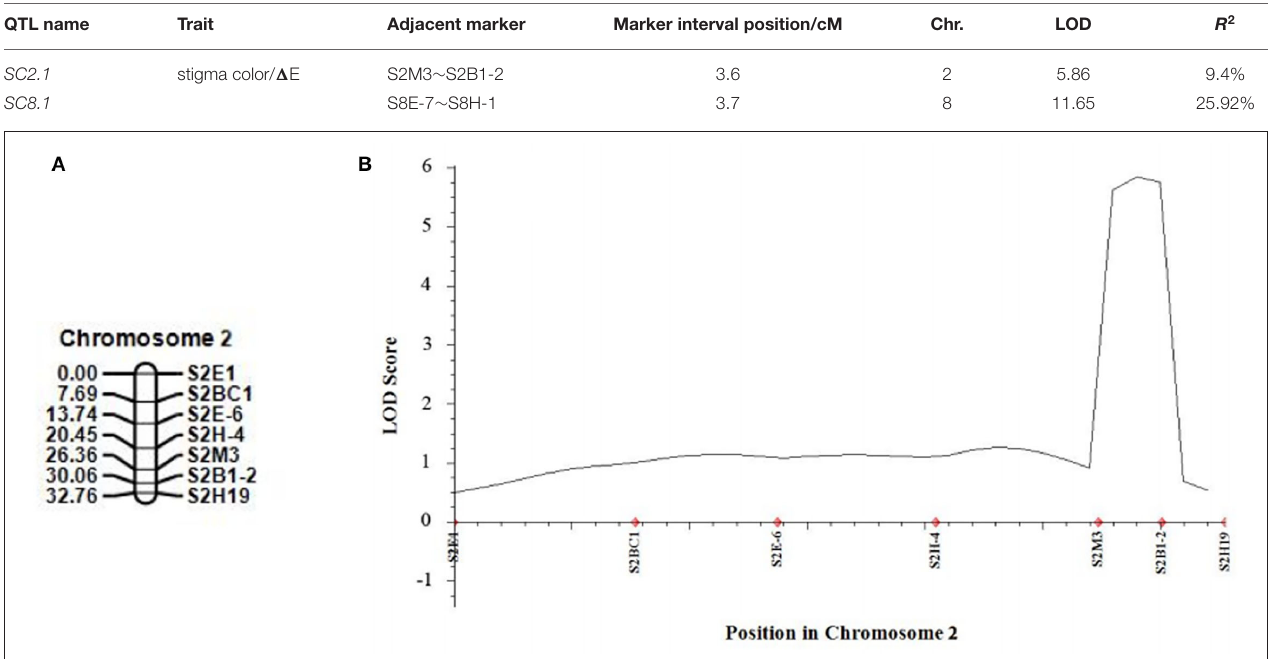
TABLE 4 | Quantitative traits locus (QTL) analysis of melon stigma color using expanded F 2 population.